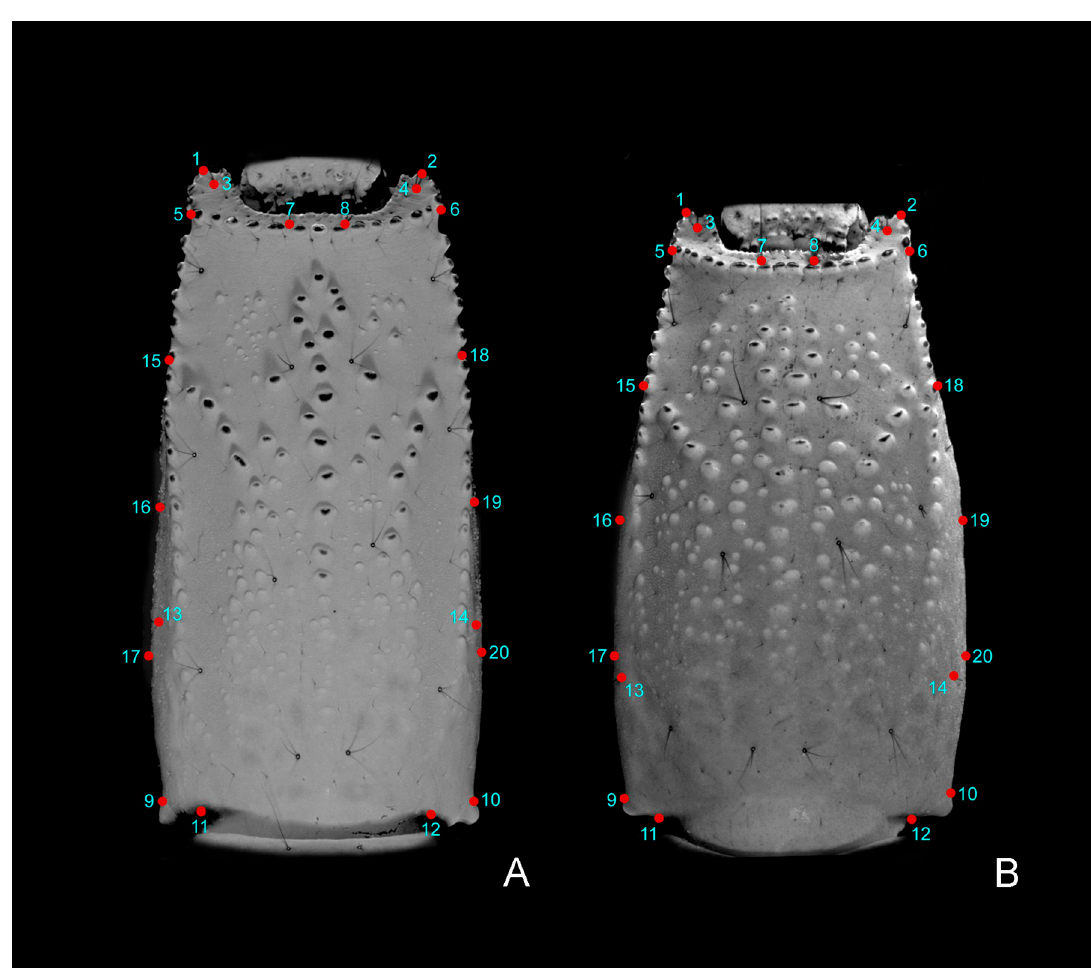
Fig 3. General description of the location of the 20 landmarks in the ventral surface of metasomal segment V. (A) Bothriurus mistral n. sp. (B) Bothriurus coriaceus